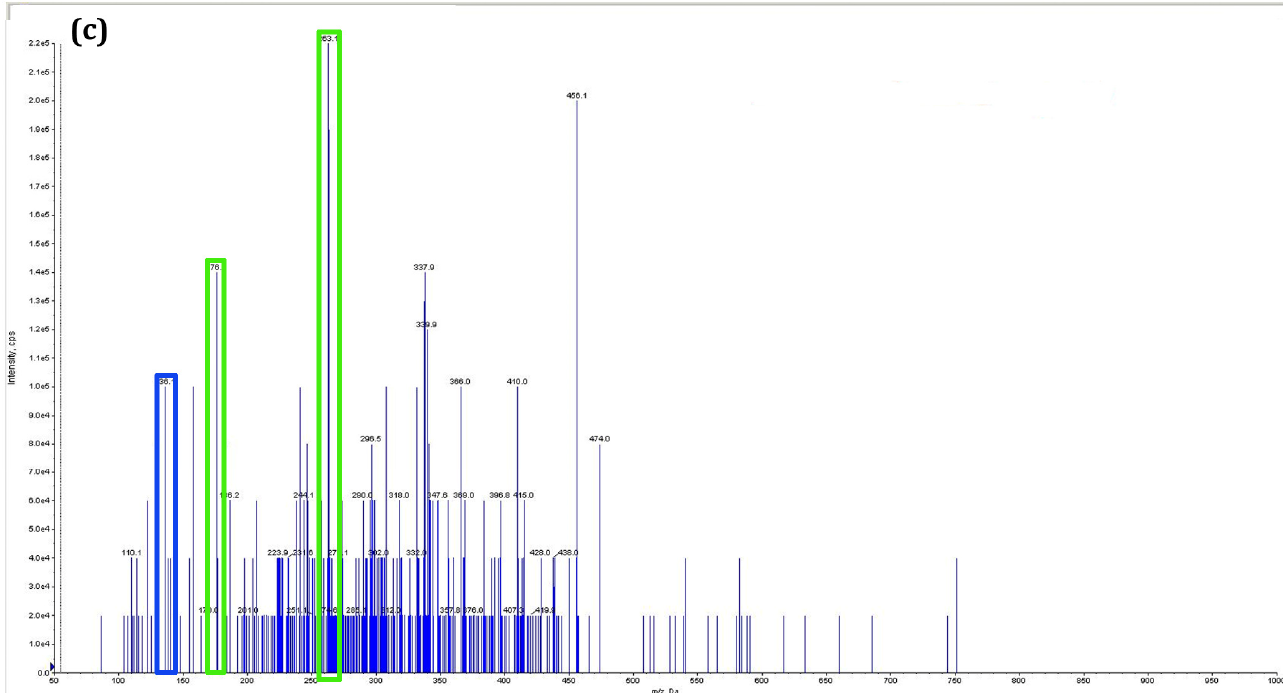
Figure 5. Mass spectrometry analysis: ( a ) MS/MS spectrum of AMP; adenine peak m / z at 136.2 is highlighted in blue color. ( b ) MS/MS spectrum of streptomycin; two peaks m / z at 263.2 and 176.2 are highlighted in green color ( c ) MS/MS spectrum of adenylated streptomycin. The stronger spectrum of m / z at 136.2 from AMP and m / z at 263.2 and 176.2 from streptomycin, commonly observed in adenylated streptomycin, is highlighted in blue and green color, respectively.